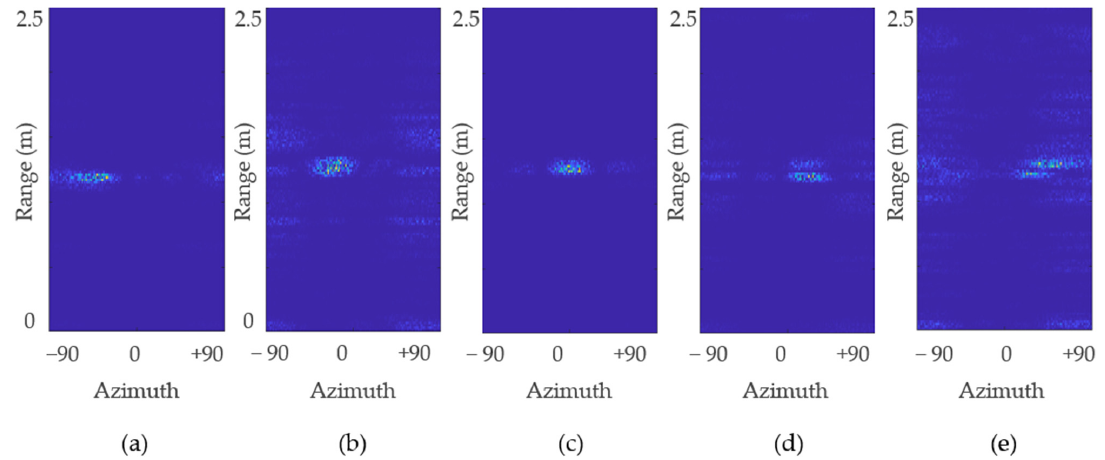
Figure 9. Range–angle map for: ( a ) − 40°; ( b ) − 20°; ( c ) 0°; ( d ) 20°; and ( e ) 40° measured when the target was located at 1.2 m.